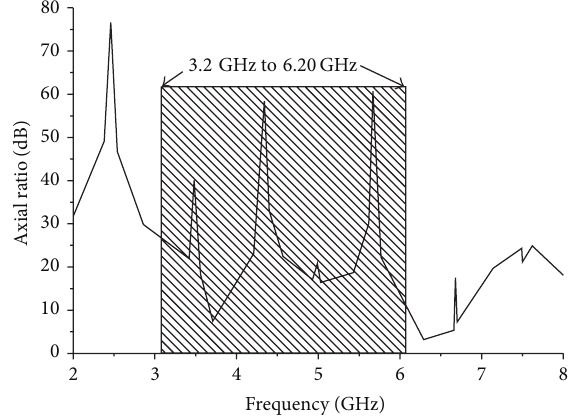
Figure 10: Axial ratio of the proposed antenna.